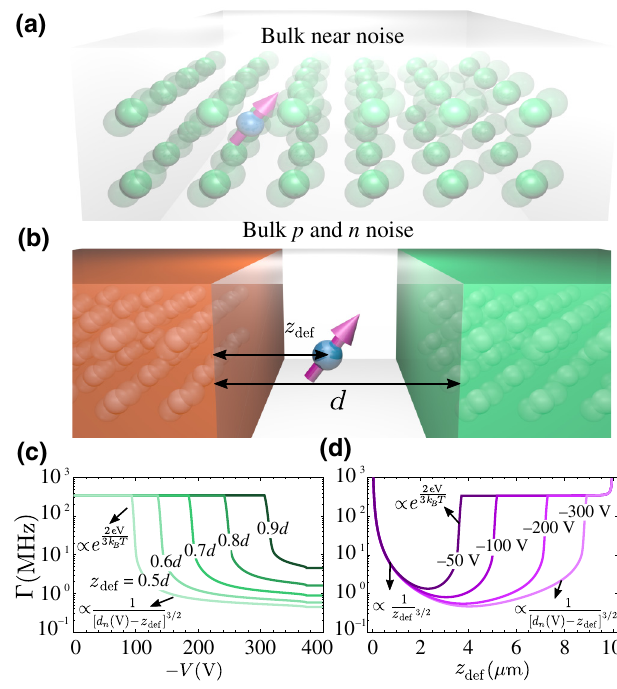
FIG. 5. The electric noise arising from (a) the n region (bulk near noise contribution) and (b) both p and n + regions (bulk p and n noise contribution). (c) Broadening (cid:12) as a function of reverse voltage for different z def values due to both the bulk near noise contribution and the bulk p and n noise